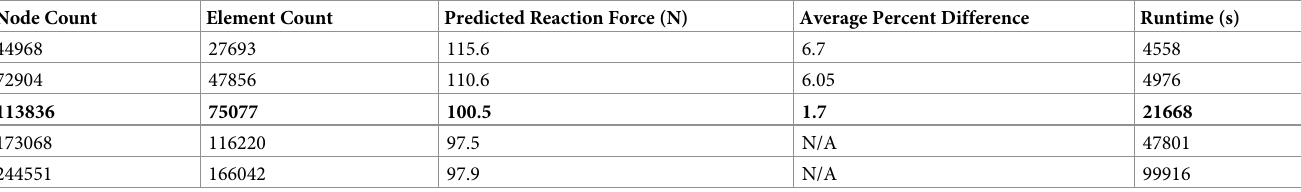
Table 3. Mesh convergence results on female upper leg model. Node